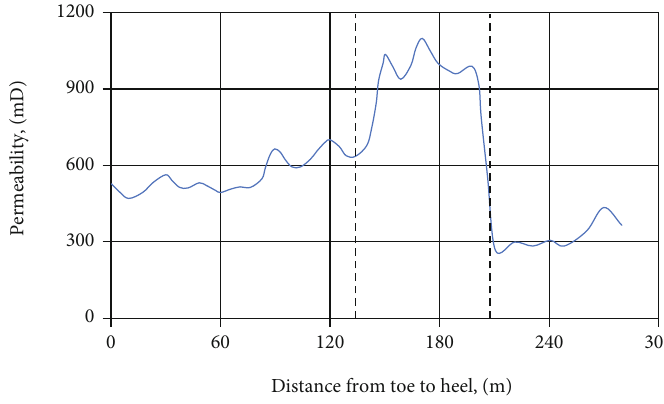
Figure 13: Distribution of permeability along the wellbore. Table 3: Injection data of Well